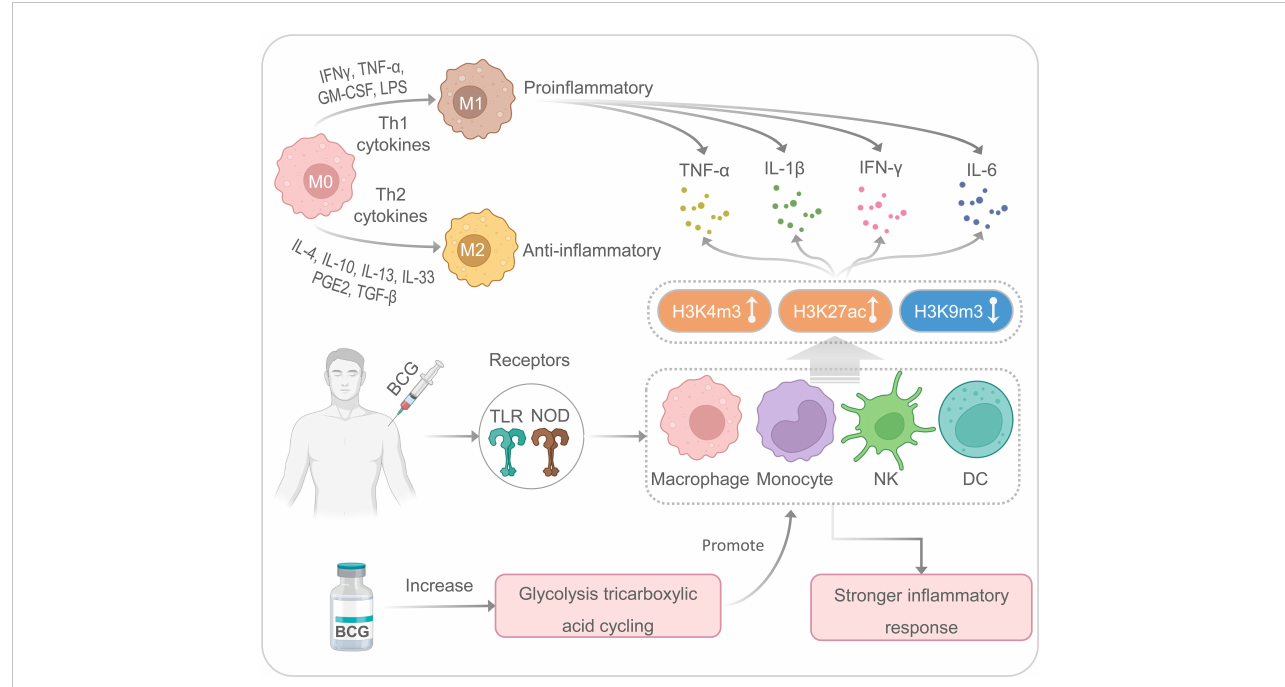
FIGURE 2 The nonspeci fi c immune responses induced by the BCG. M, macrophages; NK, natural killer cells; DC, dendritic cells.